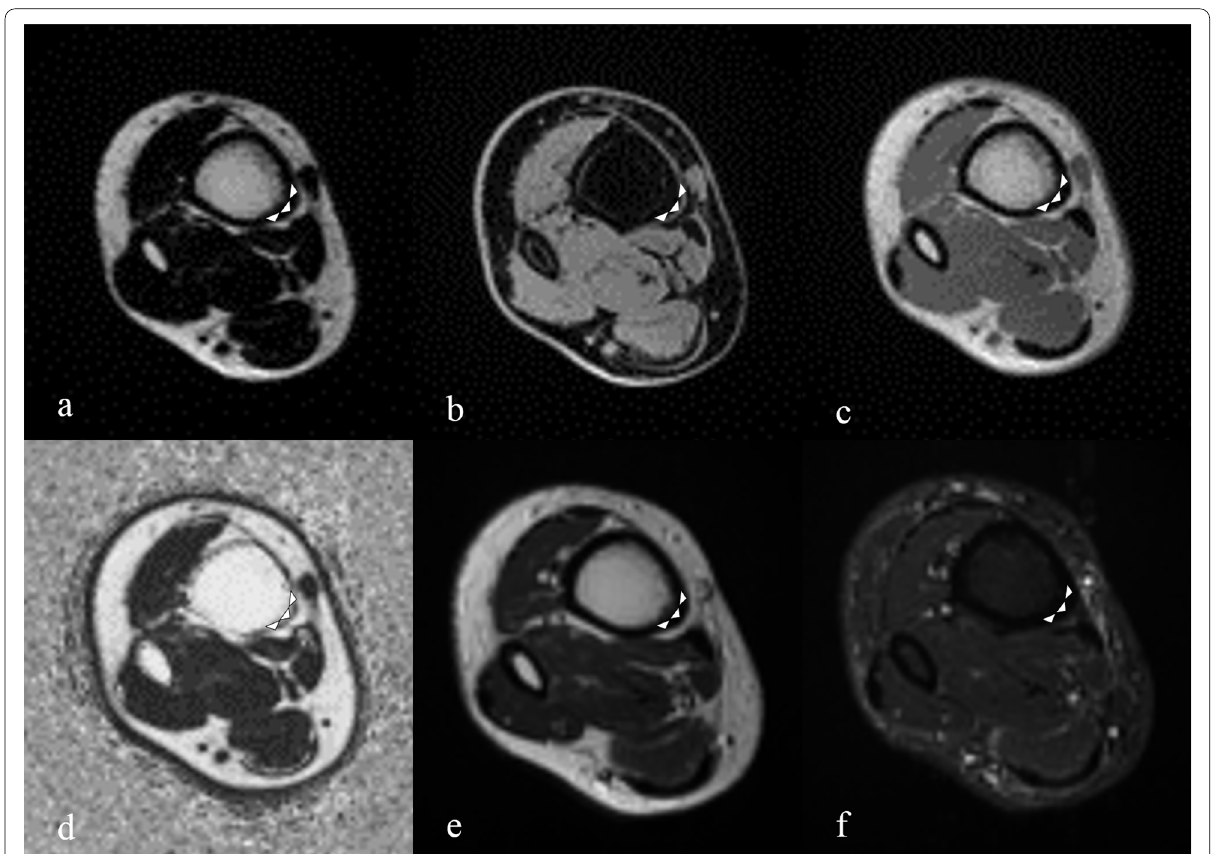
Fig. 2 A 23-year-old man. Images in transverse plane were acquired 6 cm from the distal tip of the medial malleolus. a : Fat-only image obtained using LAVA-Flex. b : Water-only image obtained using LAVA-Flex. c : In-phase image (same T1-weighted imaging) obtained using LAVA-Flex. d : Fat fraction image obtained using Ideal IQ. e : T2-weighted image. f : short-tau inverse recovery (STIR). Adipose tissue positioned on the posteromedial tibial border (white arrowheads). The adipose tissue shows high signal intensity on fat-only, in-phase, fat fraction, and T2-weighted images. On the other hand, the adipose tissue shows low signal intensity on water-only and STIR